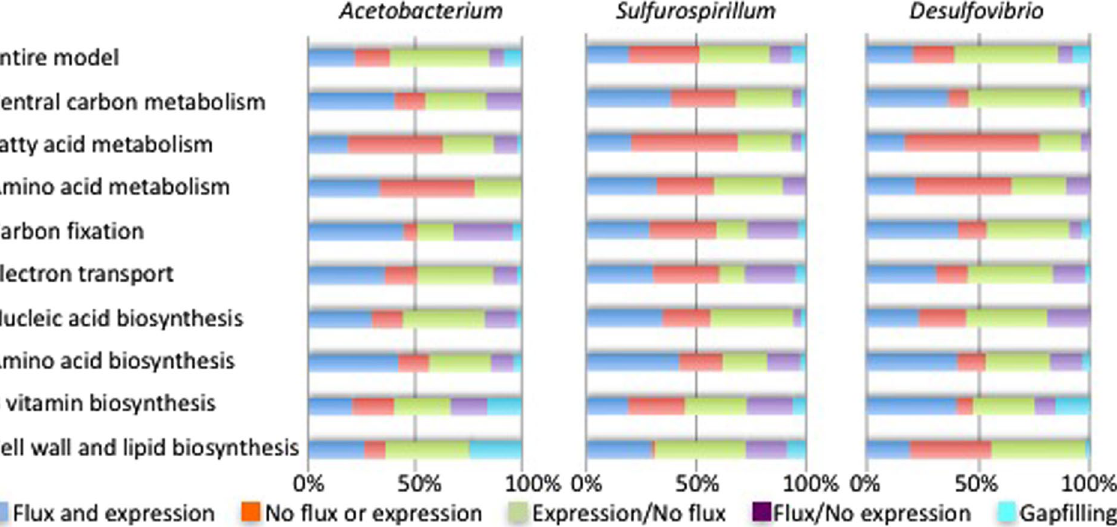
Figure 4. Pathway flux and model agreement with expression data. The degree of agreement between the model-based flux predictions and expression data for each of the three metabolic models is shown, both for the entire models and broken down by categories of metabolism. In the graph, reactions are divided into five categories based on their flux and the expression of their associated genes: (i) reactions that are active and associated with at least one expressed gene (dark blue); (ii) reactions that are inactive and associated only with unexpressed genes (dark red); (iii) reactions that are inactive and associated with one or more expressed genes (green); (iv) reactions that are active and associated only with unexpressed genes (purple); and (v) gapfilled reactions associated with no genes. The dark blue and dark red categories indicate agreement between the models and expression data; purple and green categories indicate disagreement.